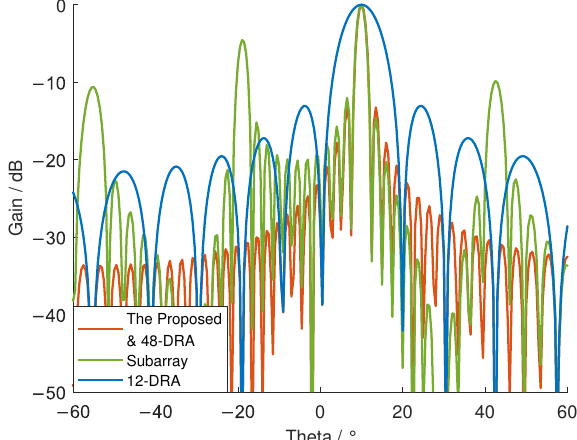
Figure 7. The normalized spectrum diagram of the decoded signal after DBF with input SNR = − 20 dB.